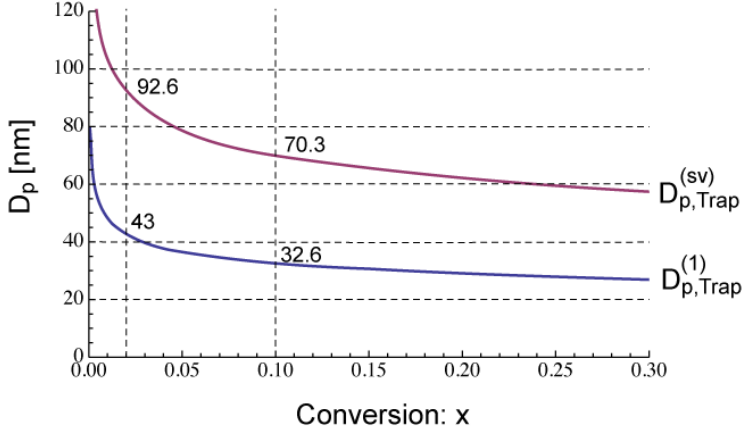
Figure 5. Calculated development of the acceleration window for the miniemulsion polymerization of SRMP-1, whose parameters are the same as Figure 3.